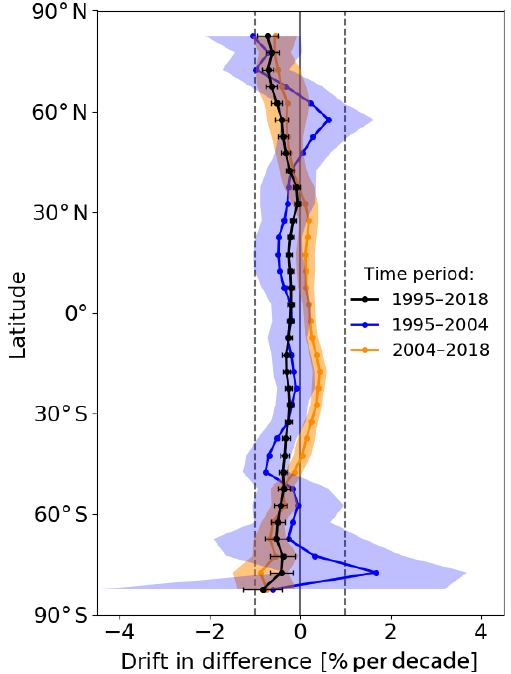
Figure 2. Linear drift in difference between adjusted MERRA-2 and GTO-ECV zonal monthly mean ozone columns as a function of latitude. Linear fit over (i) the entire period 1995–2018 (black), (ii) limited to the period 1995–2004 (blue), and (iii) limited to the period 2004–2018 (orange). Error bars and shading indicate the 2 σ errors of the linear fit coefficients, respectively.